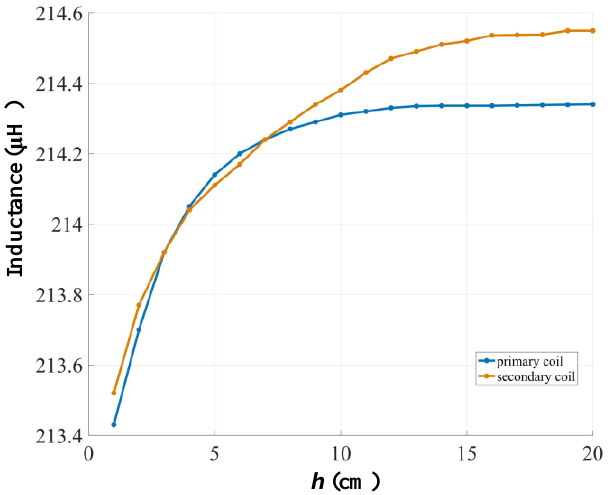
Figure 14. Inductances of the primary coil and secondary coil under different h.